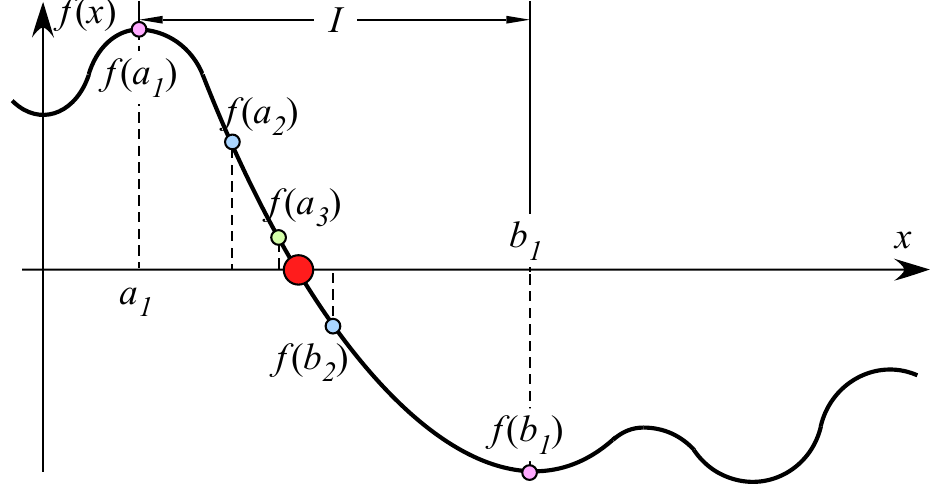
Figure 11. Illustration of the generalized trust region sub-problem (GTRS) solved by a bisection